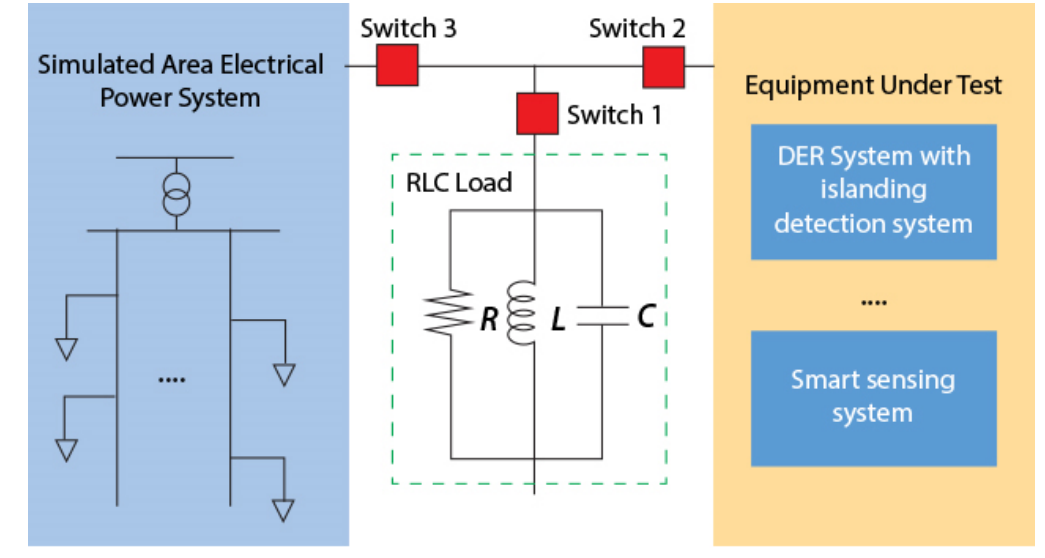
Figure 2. Unintentional islanding test